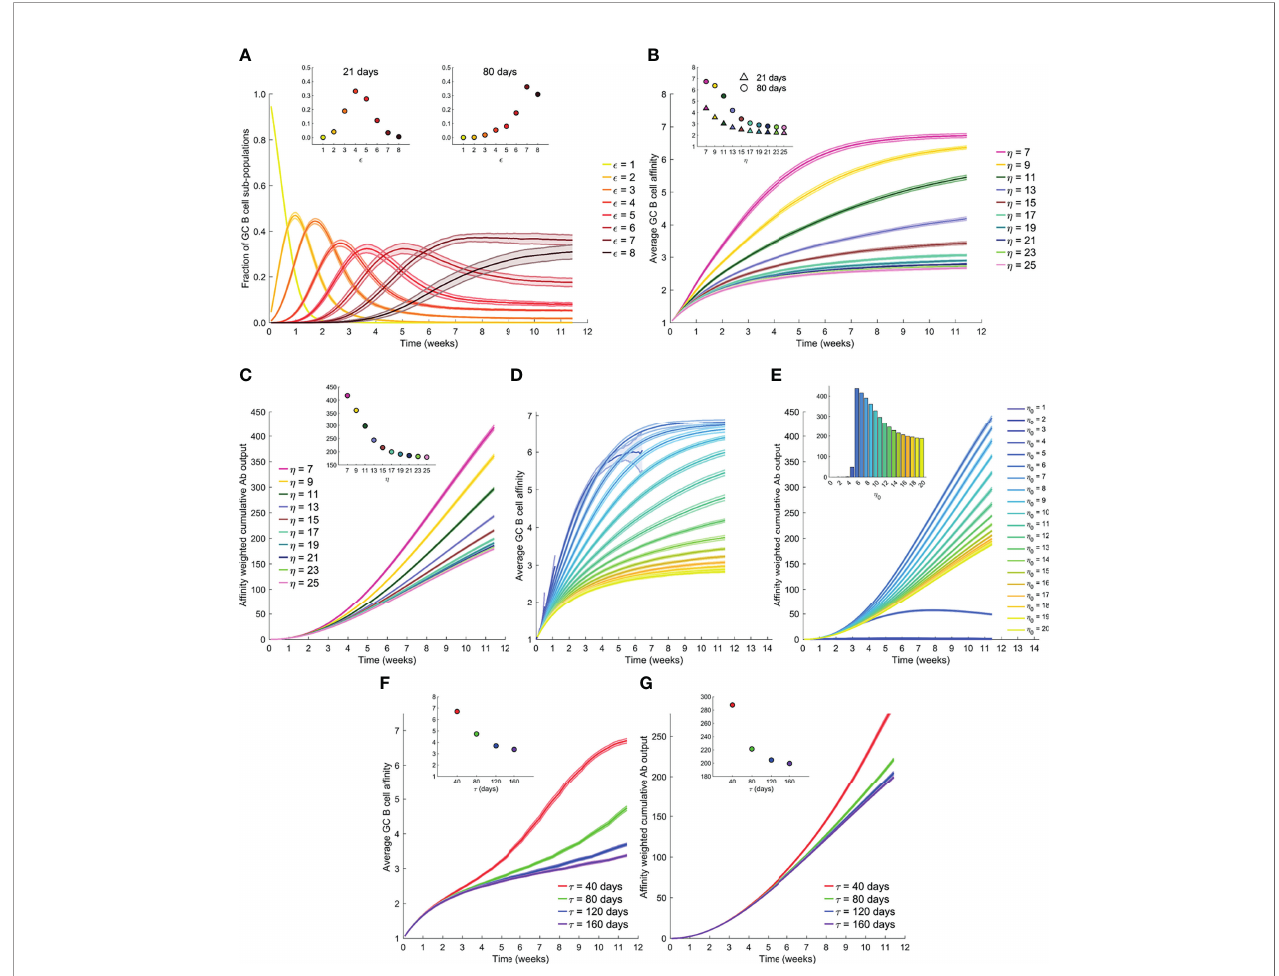
FIGURE 2 | The effect of antigen availability and half-life on the GC reaction. (A) Time-evolution of populations of GC B cells of different af fi nity, e , for the antigen; h =7. (B) Time-evolution of the average af fi nity of GC B cells for different h . Insets in (A, B) The values at day 21 and day 80. (C) Time-evolution of the af fi nity- weighted cumulative antibody output for different h . (D) Time-evolution of the average af fi nity of GC B cells for different initial h , h 0 , with antigen half-life, t =40 d. (E) Corresponding cumulative antibody output. (F) Time-evolution of the average af fi nity for different t , and with h 0 = 20. (G) Corresponding cumulative antibody output. Insets in (C, E, F, G) Corresponding values at day